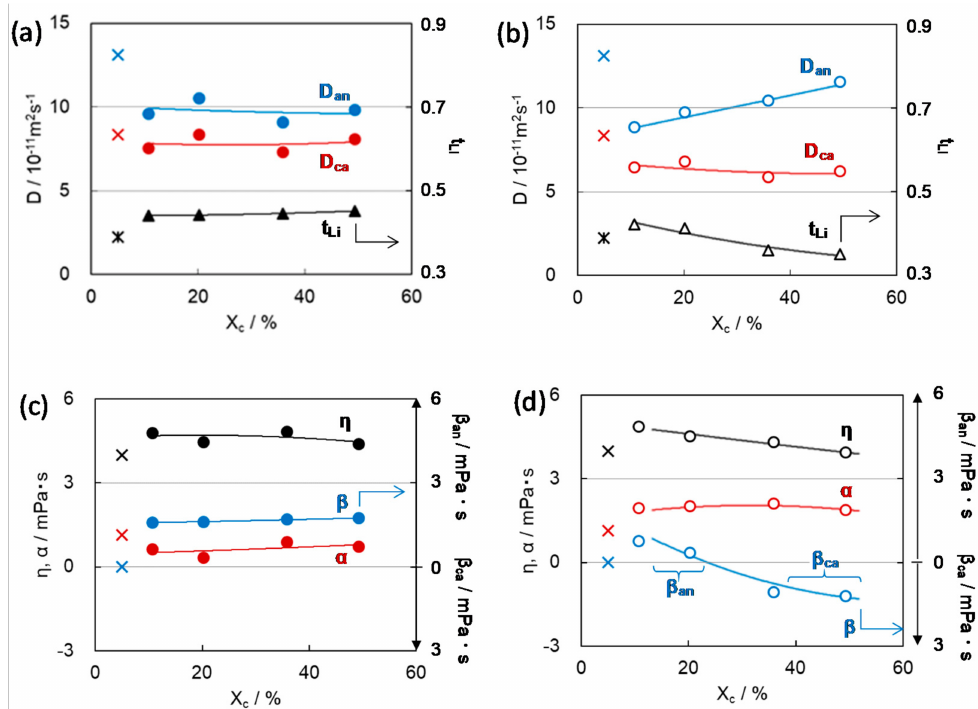
Figure 17. D ca , D an , cation transport number ( t Li ), and η , α , β of the gels composed of 90 wt% of 1 M LiTFSI/PC and 10 wt% of PVDF-based polymer prepared by ( a , c ) quenching and ( b , d ) annealing. The values of the free electrolyte solution without polymer are shown by × symbols. Reprinted with permission from [14]. Copyright 2020 ACS